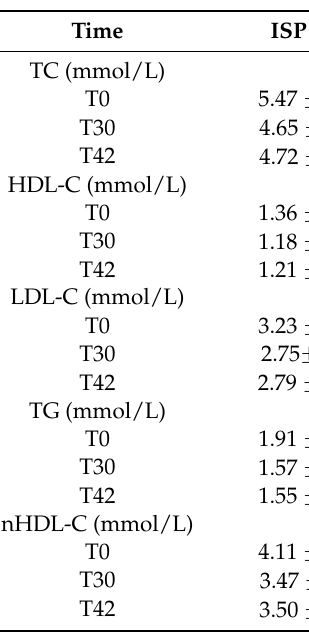
Table 3. Serum lipids levels during the